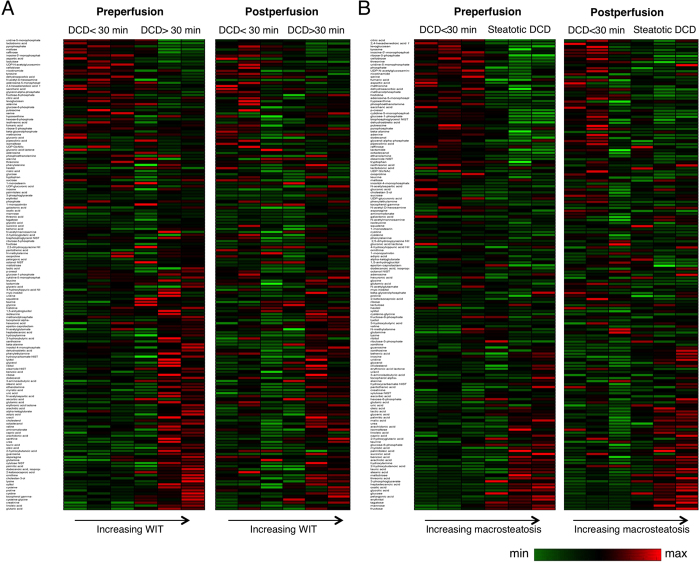
Metabolomic profile of ischemic and steatotic injury.(A) Heatmap visualization of untargeted metabolomic assessment of preperfusion and postperfusion liver grafts. DCD livers with a WIT <30 min (DCD <30 min) are compared to DCD livers with severe warm ischemia (DCD >30 min). The heatmap on the left shows the profile preperfusion and the right shows the profile postperfusion. (B) DCD <30 min livers are compared to steatotic DCD livers (right). From left to right, the macrosteatosis scores are 0, 0, 0, 2, 3, 3. The heatmap on the left shows the profile preperfusion and the right shows the profile postperfusion. Individual livers are arranged in columns with increasing warm ischemia from left to right, metabolites are ordered by slope correlating relative metabolite levels to ischemia or steatosis. The color gradient used to color the entries ranges from green to red, corresponding to relatively low and high abundance of the metabolite respectively. Both DCD >30 min and steatotic DCD livers could be discriminated from DCD <30 min livers based on their visual metabolomic pattern.